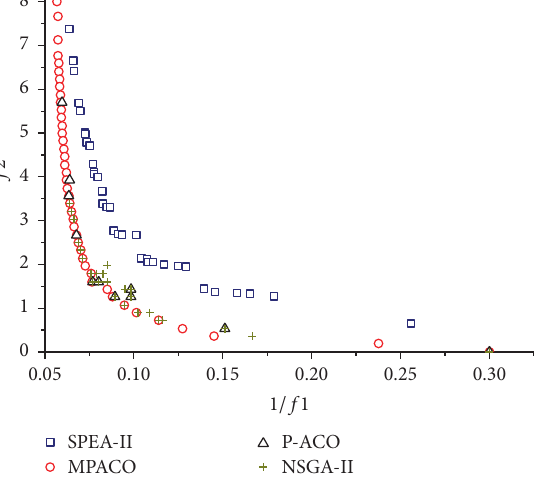
Figure 5: Plots of PSs best performance in 30 runs of four algorithms on Scale 1